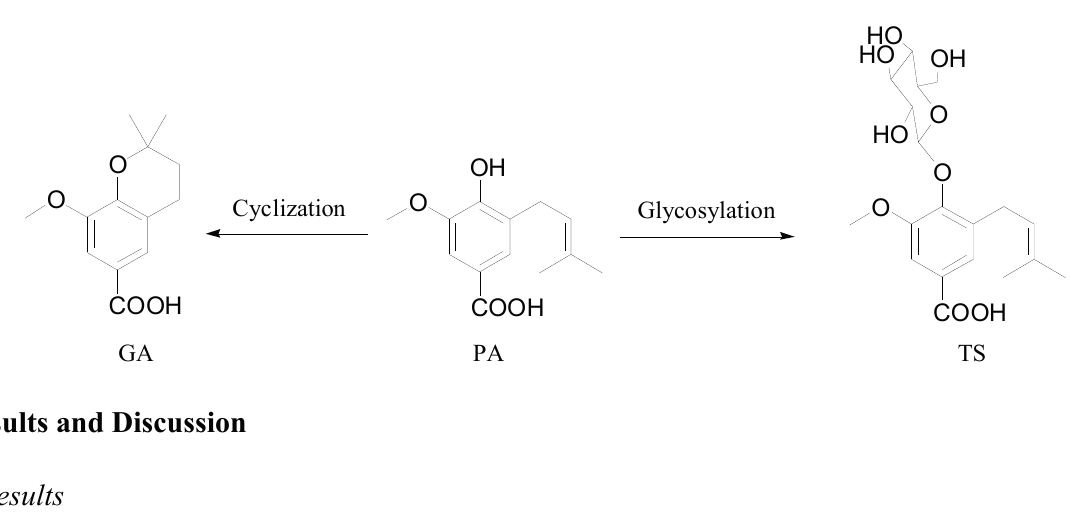
Figure 1. Chemical structures of PA, GA and